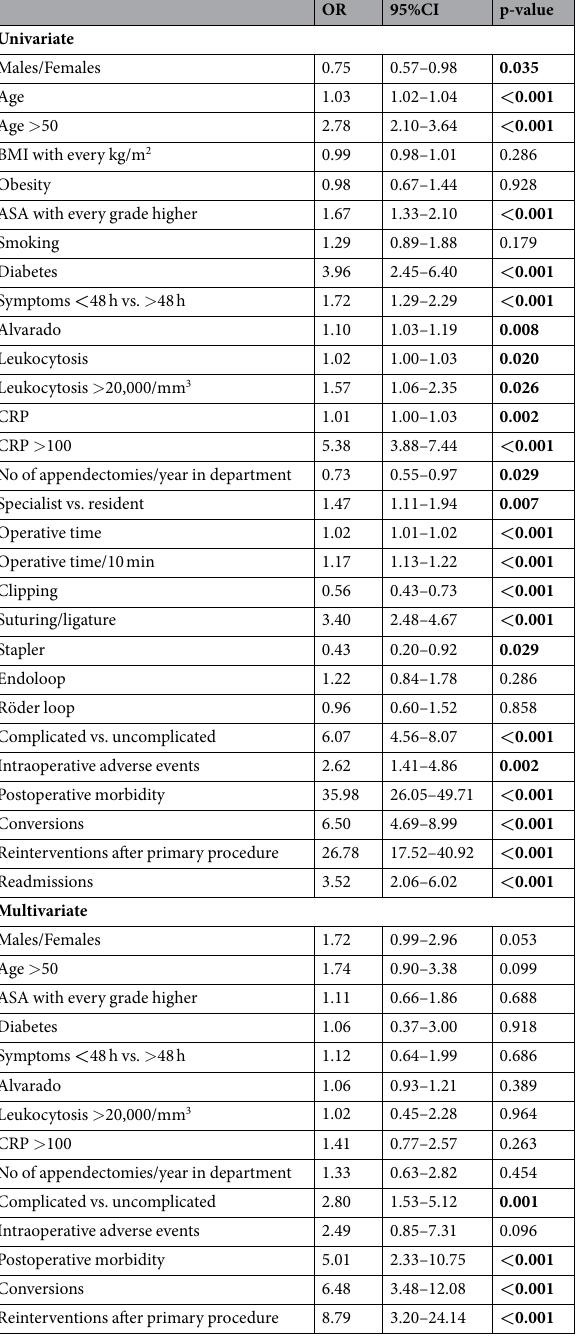
Table 3. Risk factors for prolonged